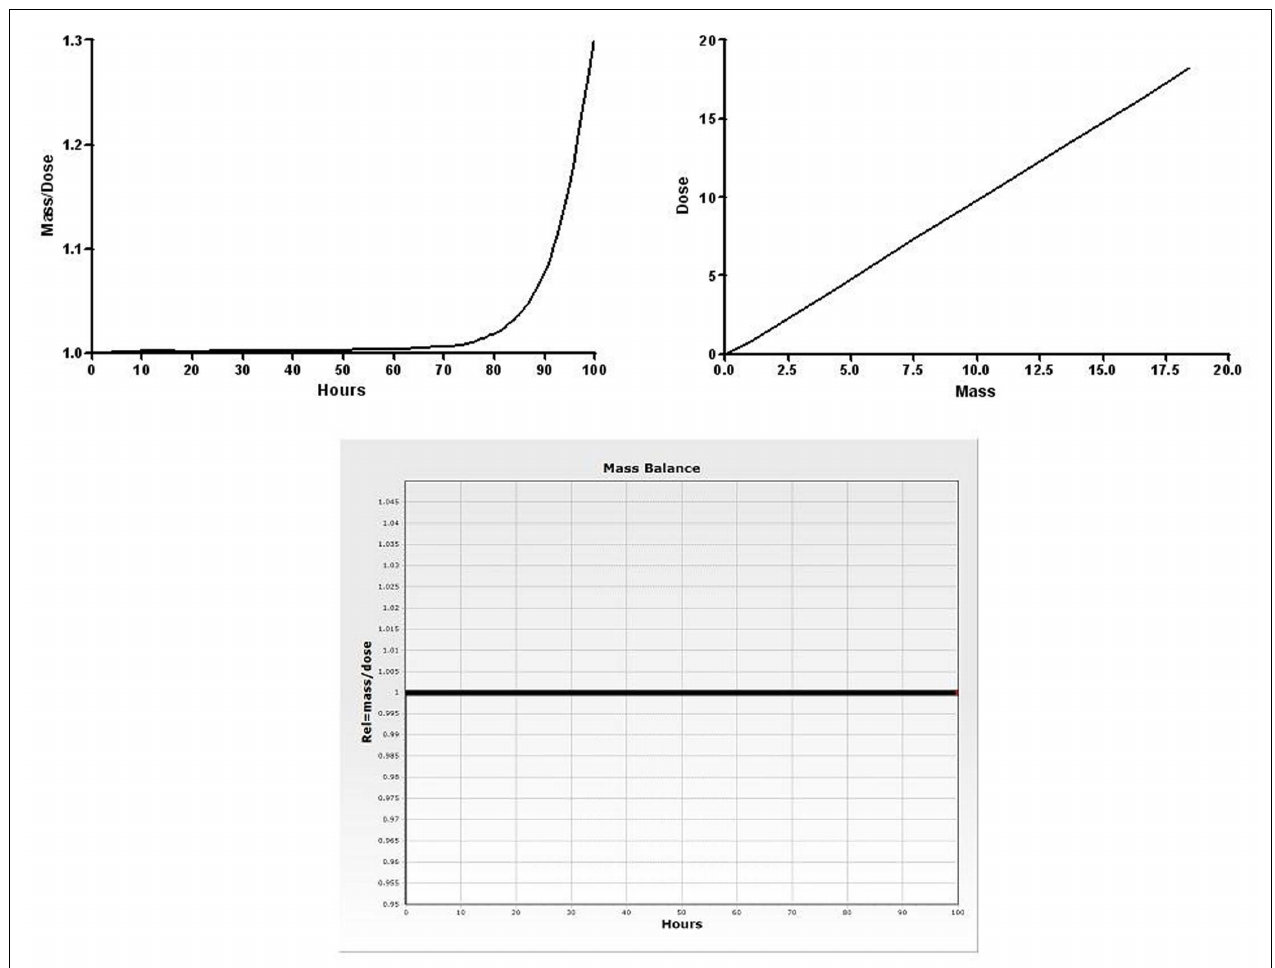
FIGURE 12 | Mass-balance check functions: quotient, dose against mass, and mass/dose quotient against time plot for the vinyl chloride model exported and visualized in acslX